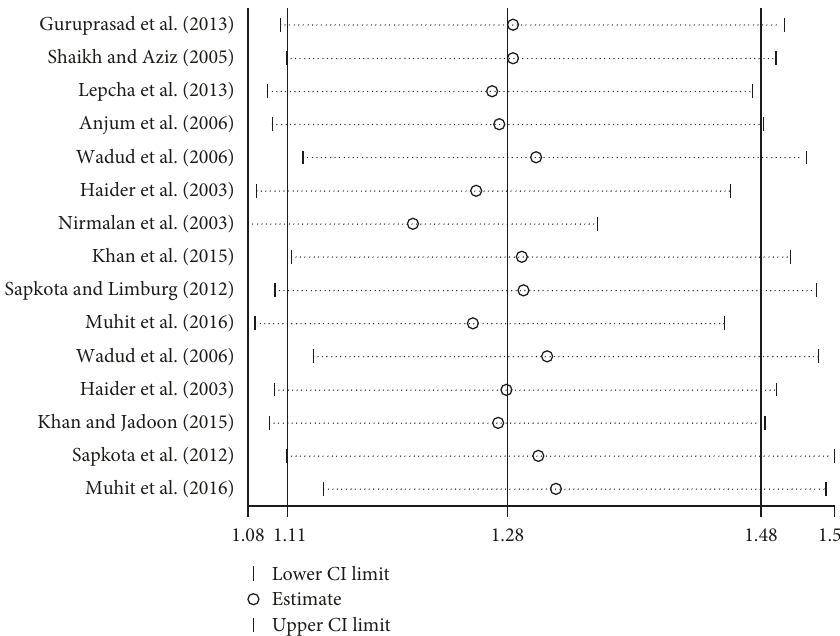
Figure 13: Sensitivity analysis of CSC on an eye. CSC � cataract surgical coverage; CI � confidence